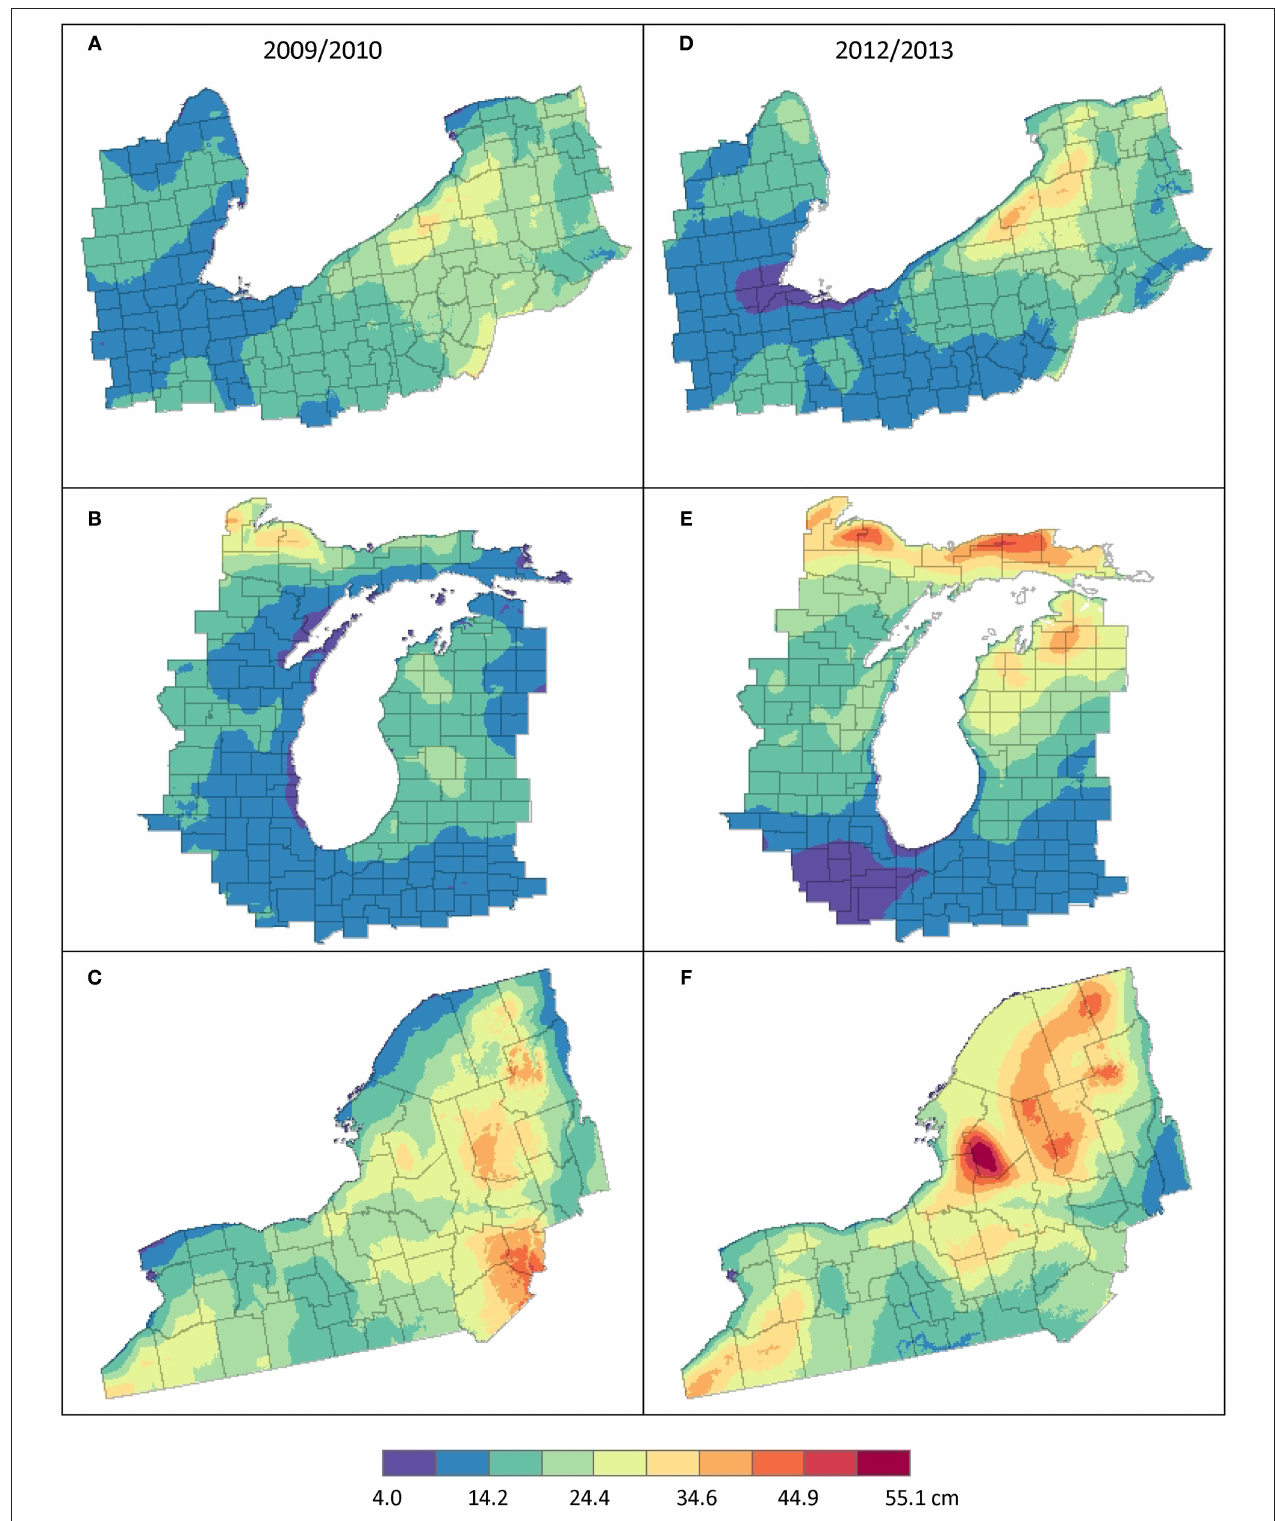
FIGURE 2 | The total cold-season LWE snowfall (cm) during the 2009/2010 season for the (A) Lake Erie, (B) Lake Michigan, and (C) Lake Ontario regions and during the 2012/2013 season for the (D) Lake Erie, (E) Lake Michigan, and (F) Lake Ontario regions.